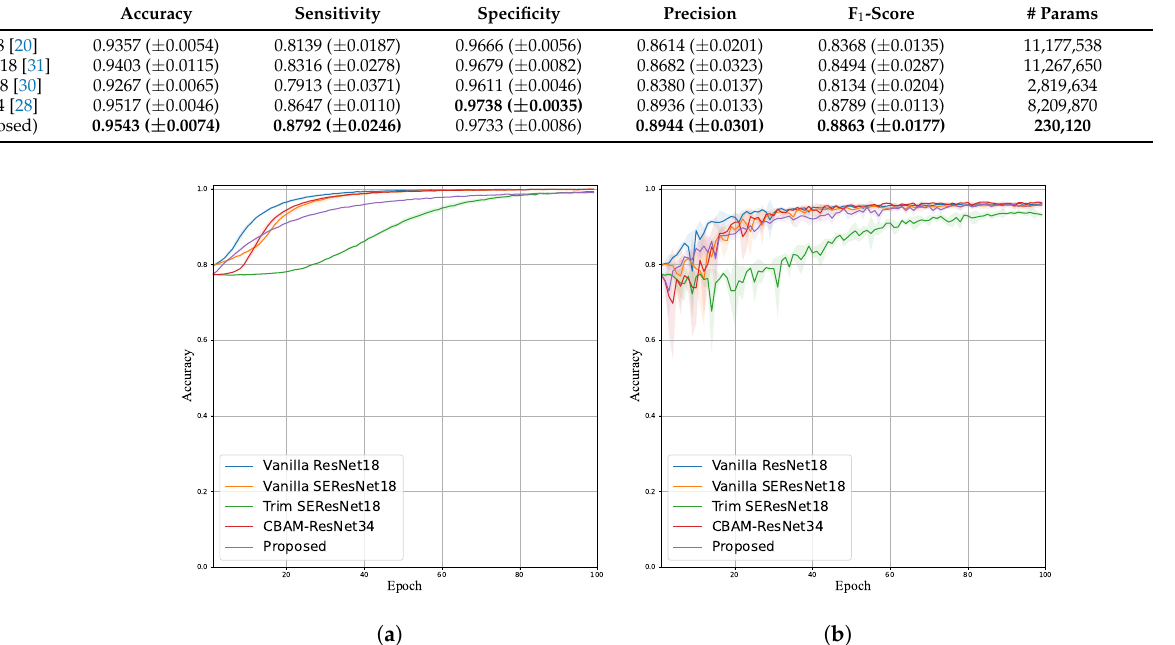
Figure 8. ( a ) Training and ( b ) Validation accuracy curves of the P-ADSD evaluation.